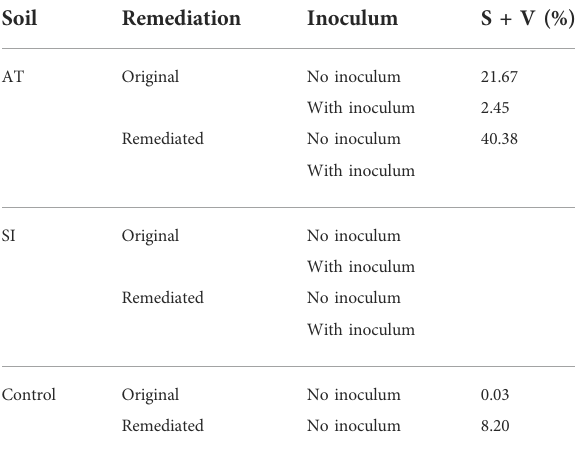
TABLE 3 Spores and vesicles abundance in the root system (S + V), sampled on 17 November 2017. Presented is measured value of one replicate per